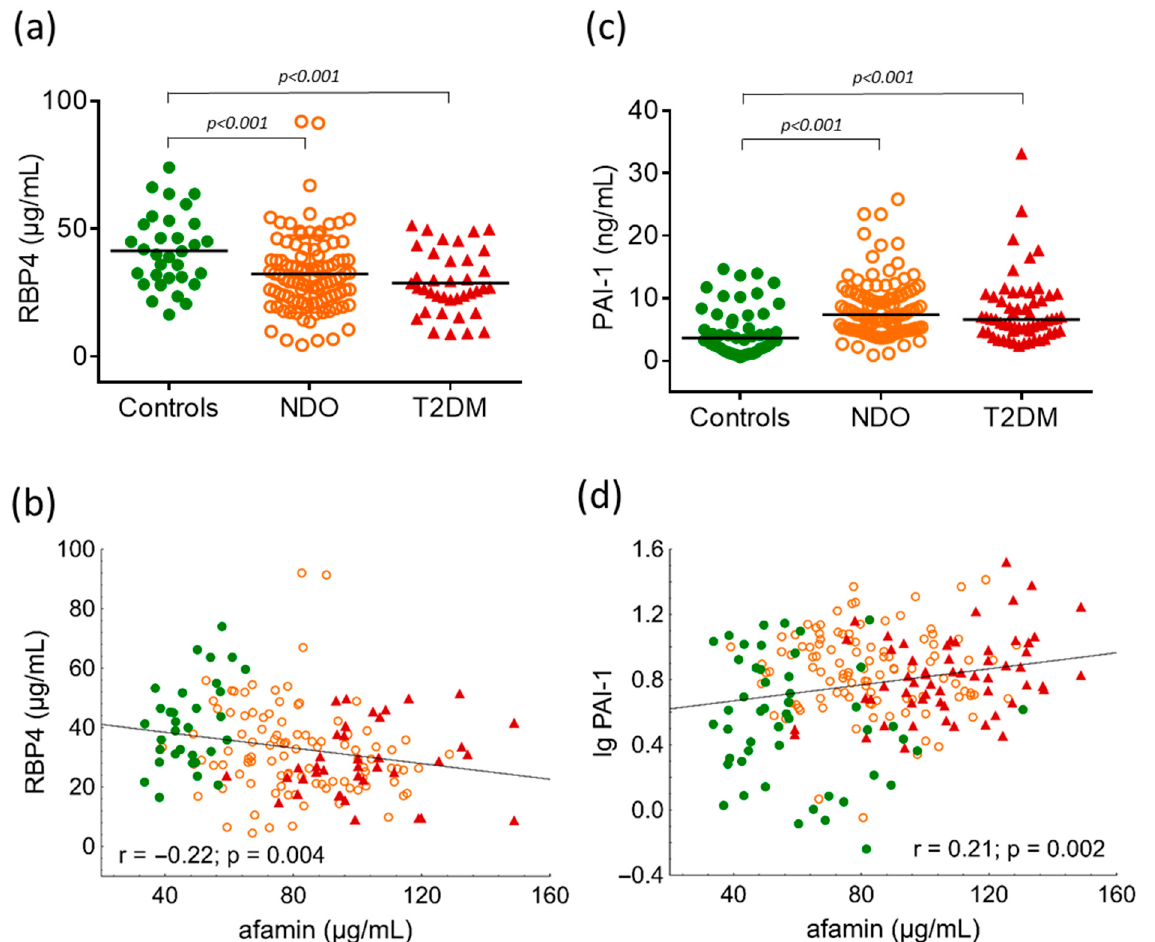
Figure 3. ( a ) Serum levels of retinol binding protein 4 (RBP4) in study groups; ( b ) correlation between RBP4 and afamin in overall subjects; ( c ) plasma levels of plasminogen activator inhibitor-1 (PAI-1) in study groups; and ( d ) correlation between PAI-1 and afamin in overall subjects. Differences between study groups are analyzed using one-way ANOVA (RBP4) and the Kruskal-Wallis H test (PAI-1), respectively. Green dots represent healthy lean subjects (n = 49), orange dots represent non-diabetic obese patients (NDO; n = 106), and red triangles represent patients with type 2 diabetes mellitus (T2DM; n = 62). Afamin and RBP4 concentrations were quantified from peripheral blood serum samples, whereas PAI-1 levels were measured from peripheral blood EDTA-coagulated plasmas with commercially available enzyme-linked